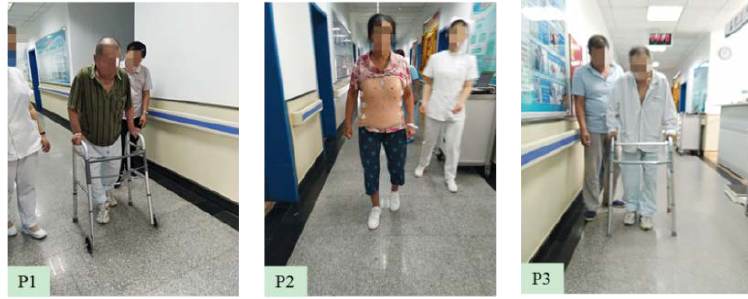
Figure 11. Photographs of the clinical trial.